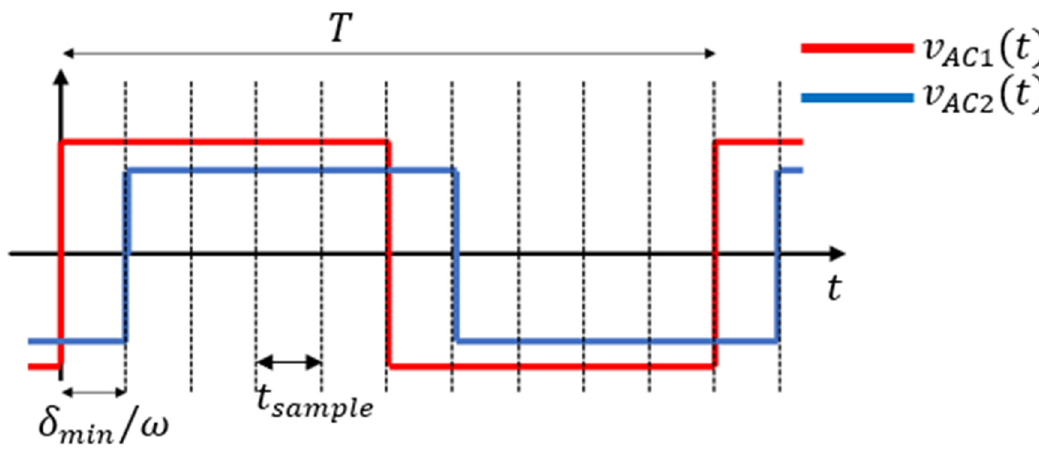
Figure 8. Waveforms of DAB converter and sample time. The value of δ min is calculed in Equation (21).